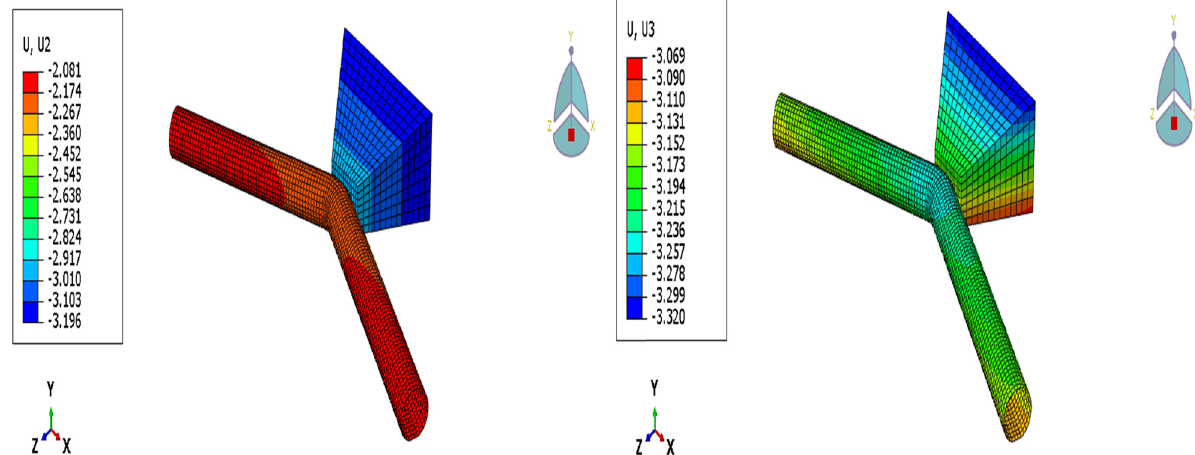
Figure 13: Vertical displacement of thrust block ( mm ) .